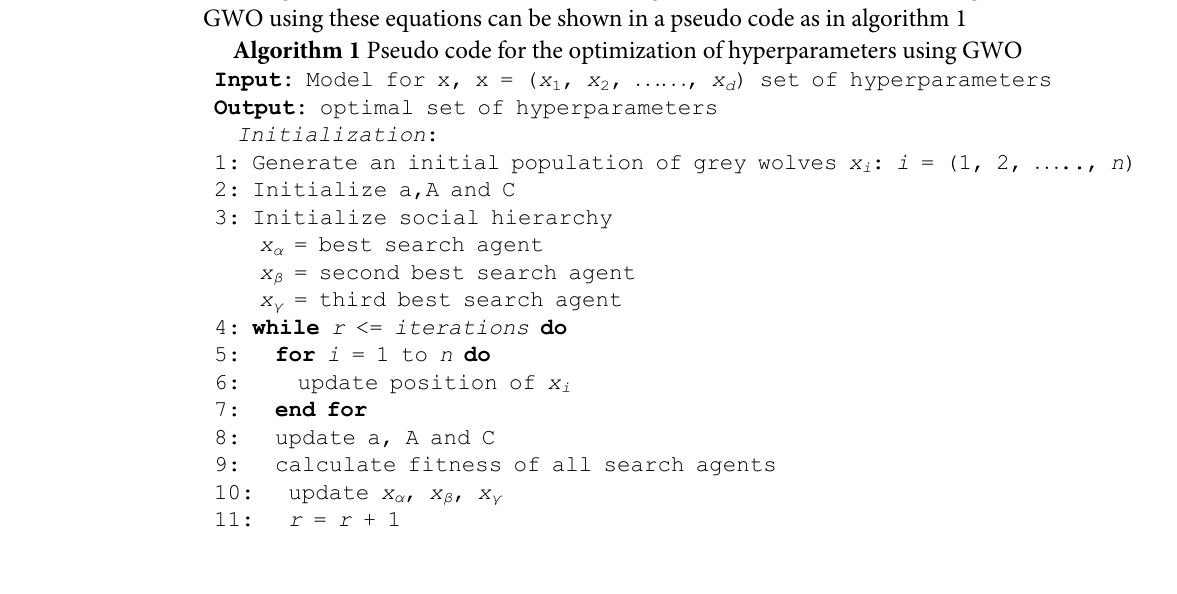
Algorithm 1 Pseudo code for the optimization of hyperparameters using